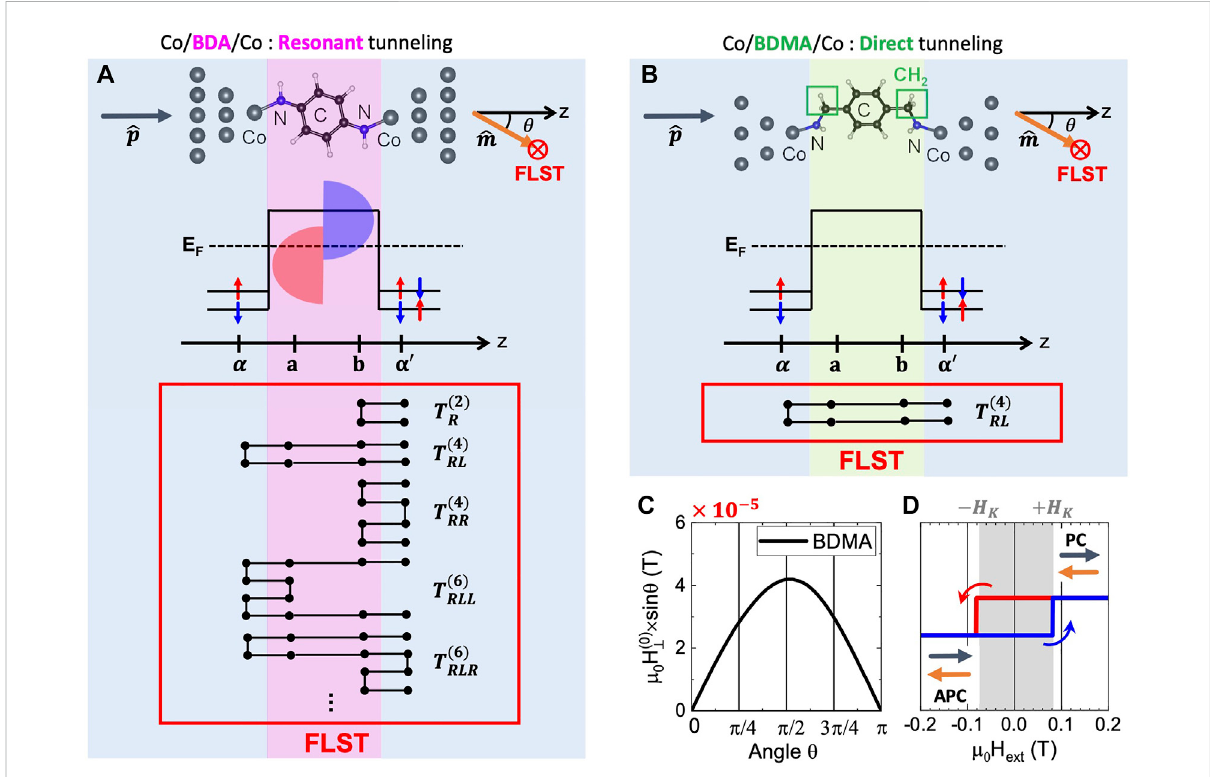
FIGURE 5 [Top] Junction geometries, [Middle] schematic of energy pro fi le, and [Bottom] schematic of multi-re fl ection paths of T ⊥ (cid:3) Q y 0 for (A) resonant tunnelingviaspinterfaceeffectofCo/BDA/CoSMMJsand (B) directtunnelingforCo/BDMA/CoSMMJs.Theredandblueshadedareasrepresentthe pronounced π -resonantspin-polarizeddensityofstatesofcentralbarrierforBDA-case.Here α ( α ′ )isthelast( fi rst)siteofleft(right)Colead,andaand barethe fi rstandlastsitesofthecentralbarrier,respectively. (C) AngulardependenceofequilibriumFLST fi eld, μ 0 H ( 0 ) ⊥ × sin θ and (D) the JUNPY + LLG calculated magnetic hysteresis curves ( m z -H) for Co/BDMA/Co